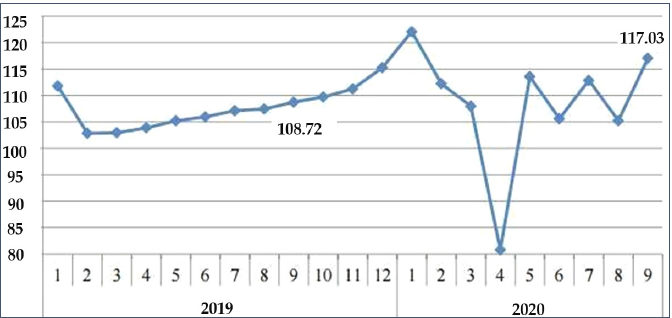
Figure 3. Weight of goods transported by road (Million tons) (Vietnam Logistics Report 2020).